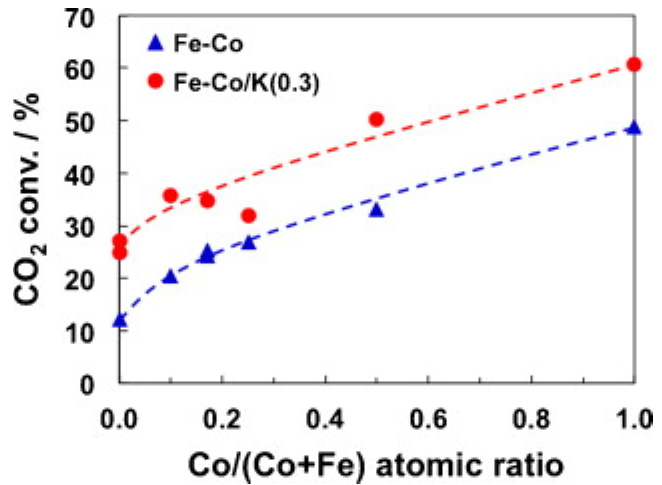
Figure 7. Effect K promotion of Fe–Co/K/Al 2 O 3 catalysts on CO 2 hydrogenation. Reproduced from Ref. [50]. Copyright license from Elsevier (2021).